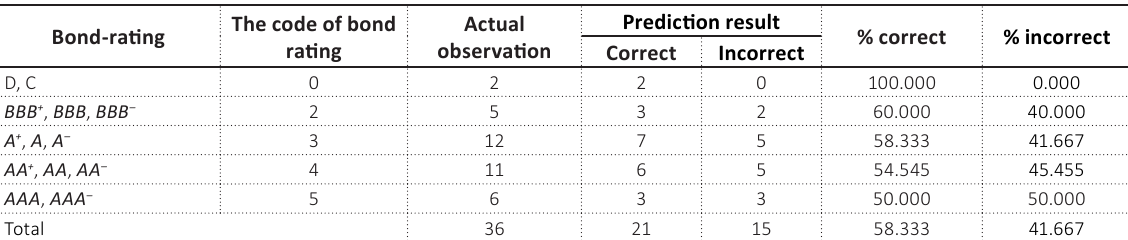
Source: Modified output of EViews